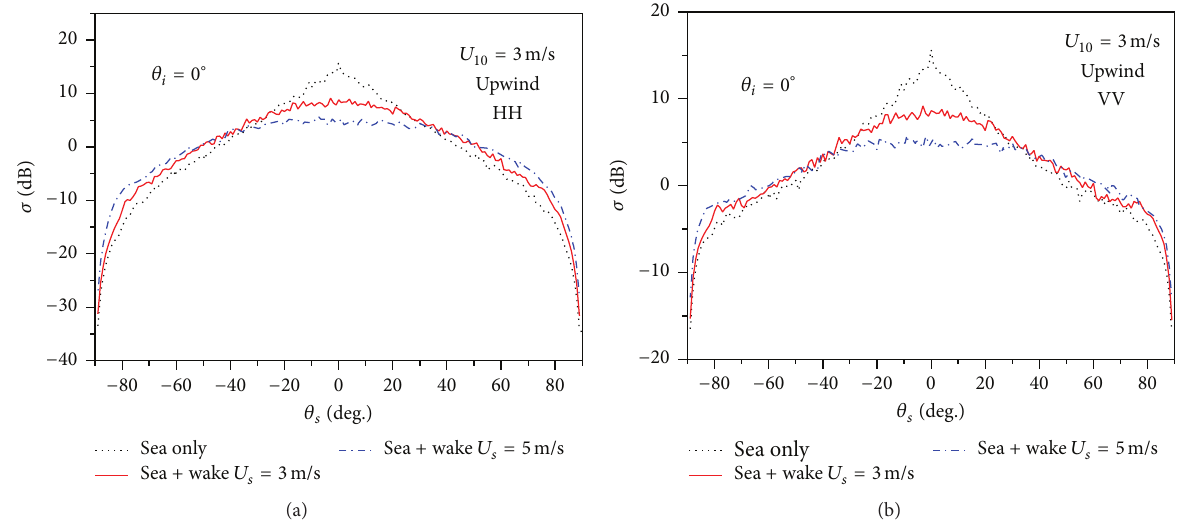
Figure 9: The angular distribution of bistatic scattering coefficient with and without an embedded ship’s Kelvin wake at a fixed wind speed = 3 m/s. (a) HH-polarization and (b) VV-polarization. 𝑈 10